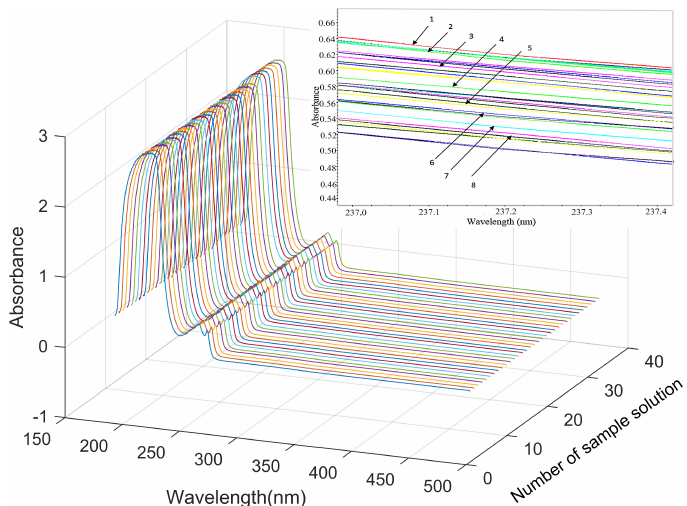
Fig. 2. The whole UV spectra of 33 solutions of PZQ from 190 nm to 500 nm. The region was selected for analysis from 287.2 nm to 236.6nm, where the maximum of absorbance was about 0.5. Inset: Expanded spectra were from 237.4 nm to 237.0 nm. The spectral bands pointed with arrows and number corresponding to the di®erent ratios of S-PZQ enantiomer (the ratio from 1 to 8 corre- sponding to 1.00, 0.96, 0.92, 0.80, 0.72, 0.68, 0.62 and 0.58,